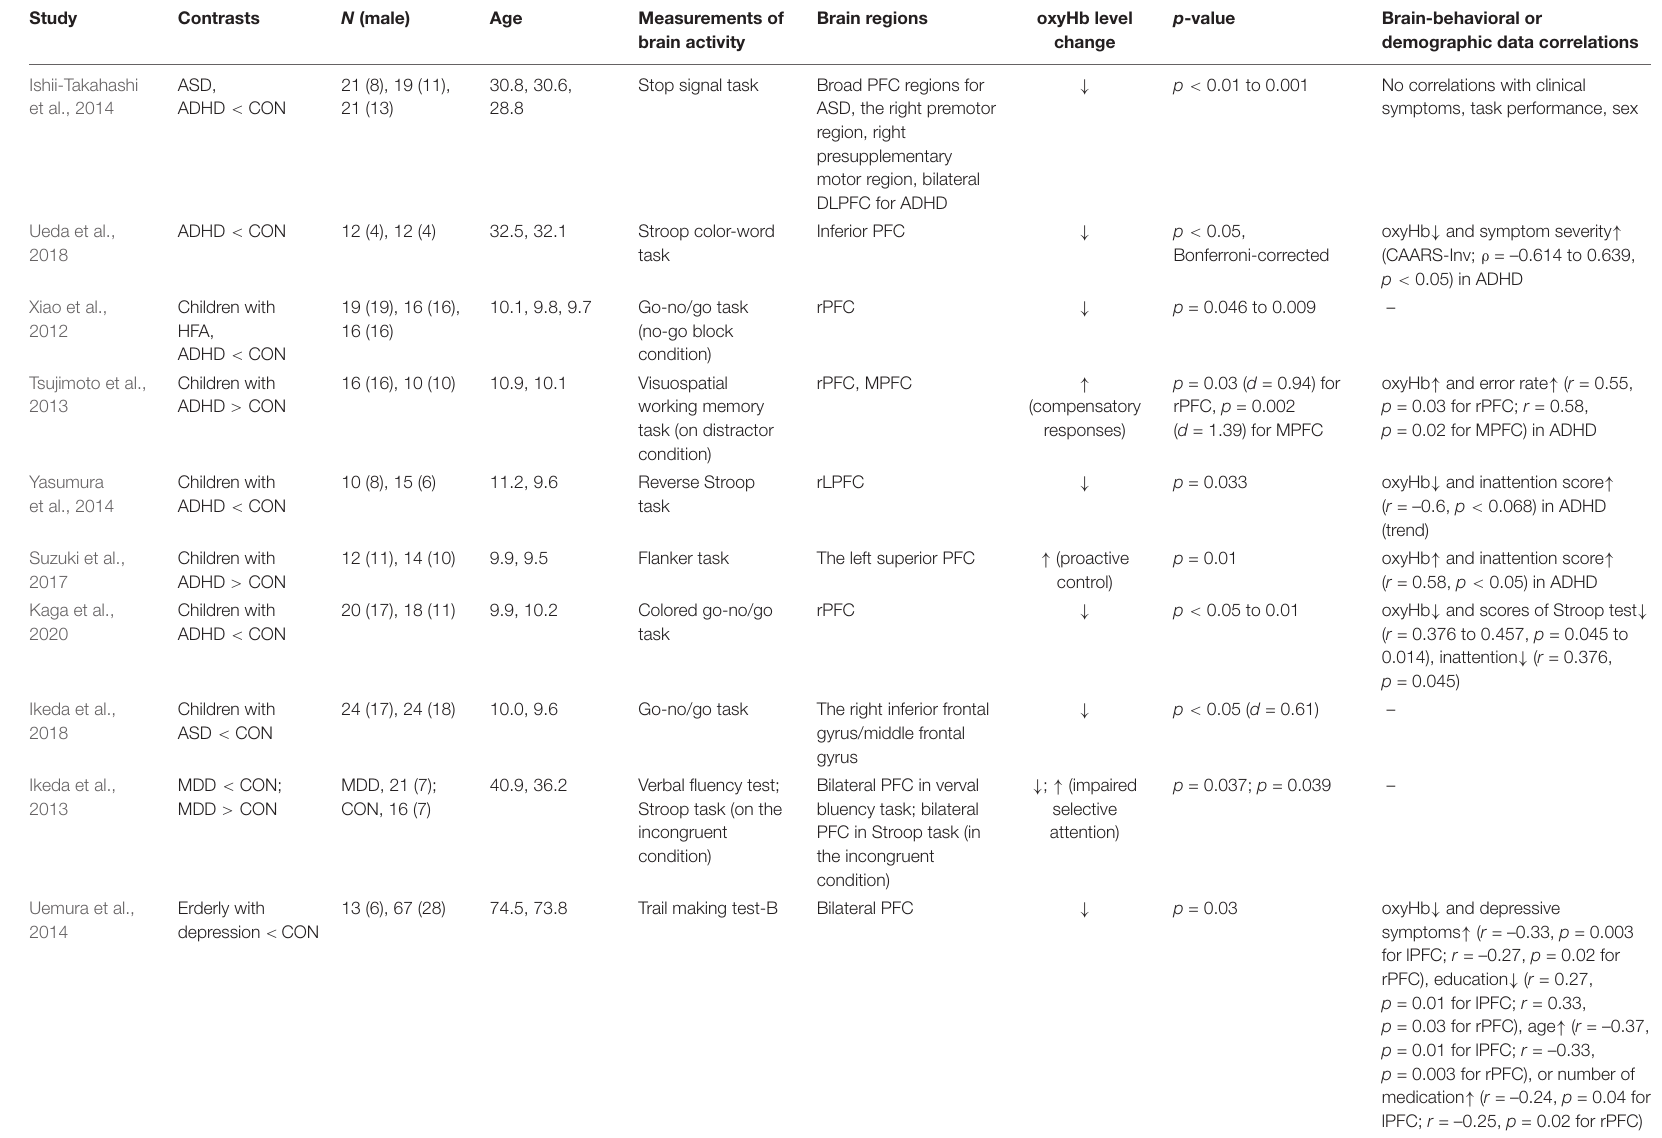
TABLE 3 | OxyHb levels changes during executive tasks in psychiatric patients in comparison with healthy